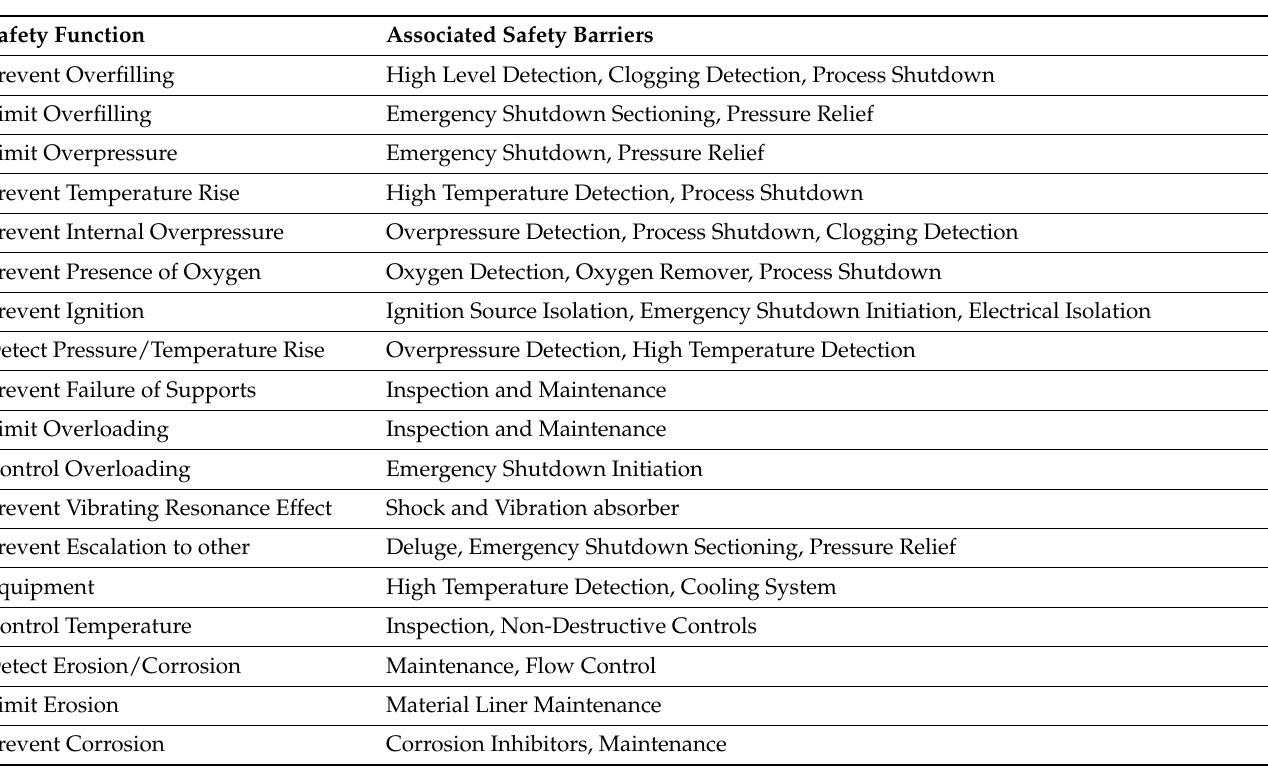
Table 5. Safety Functions from the combination of Safety